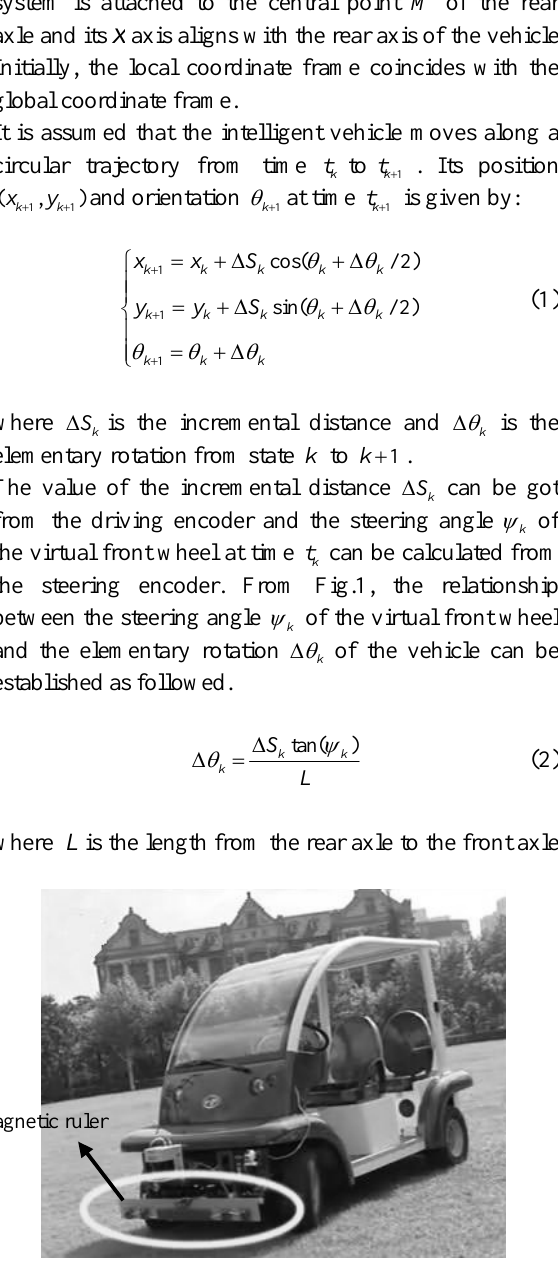
Fig. 2. Intelligent Vehicle with the Magnetic Ruler